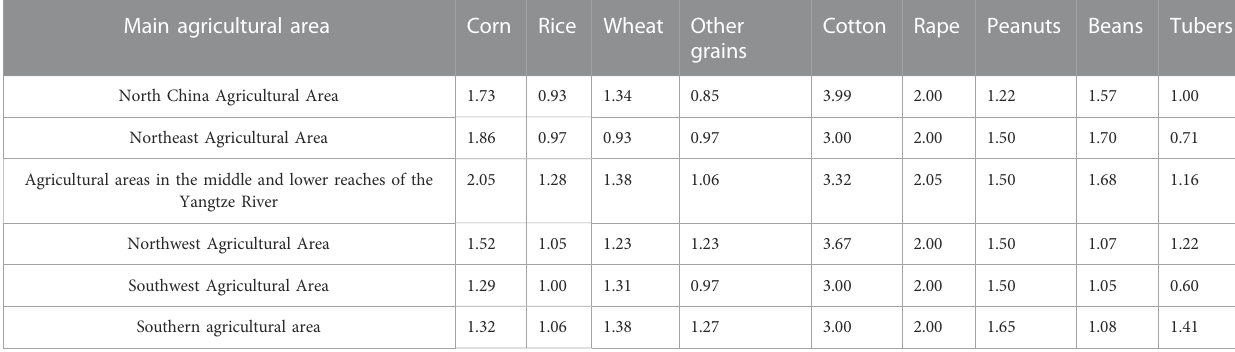
TABLE 2 Reference of main crops grain-straw ratio in different agricultural areas.